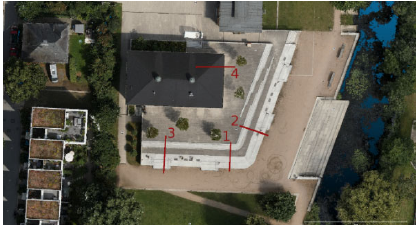
Figure 8 . Selected profiles for comparison with reference data of terrestrial scanner.